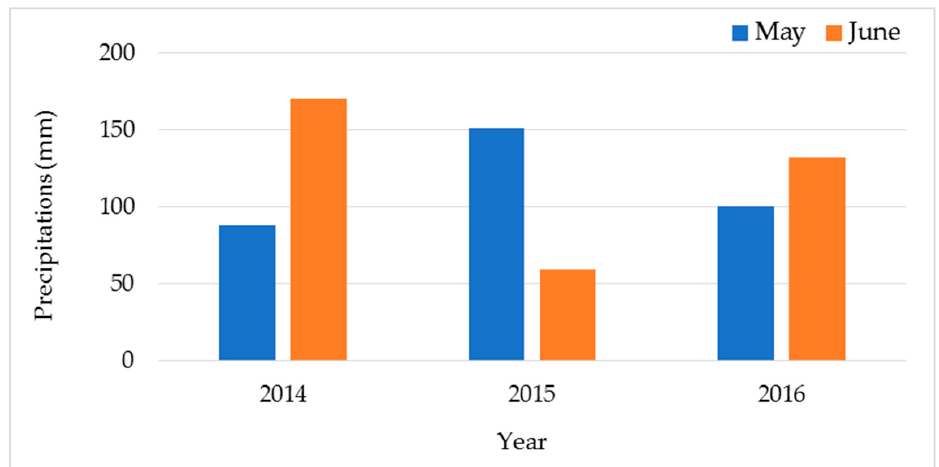
Figure 1. Rainfall in mm in May and June during three consecutive years.